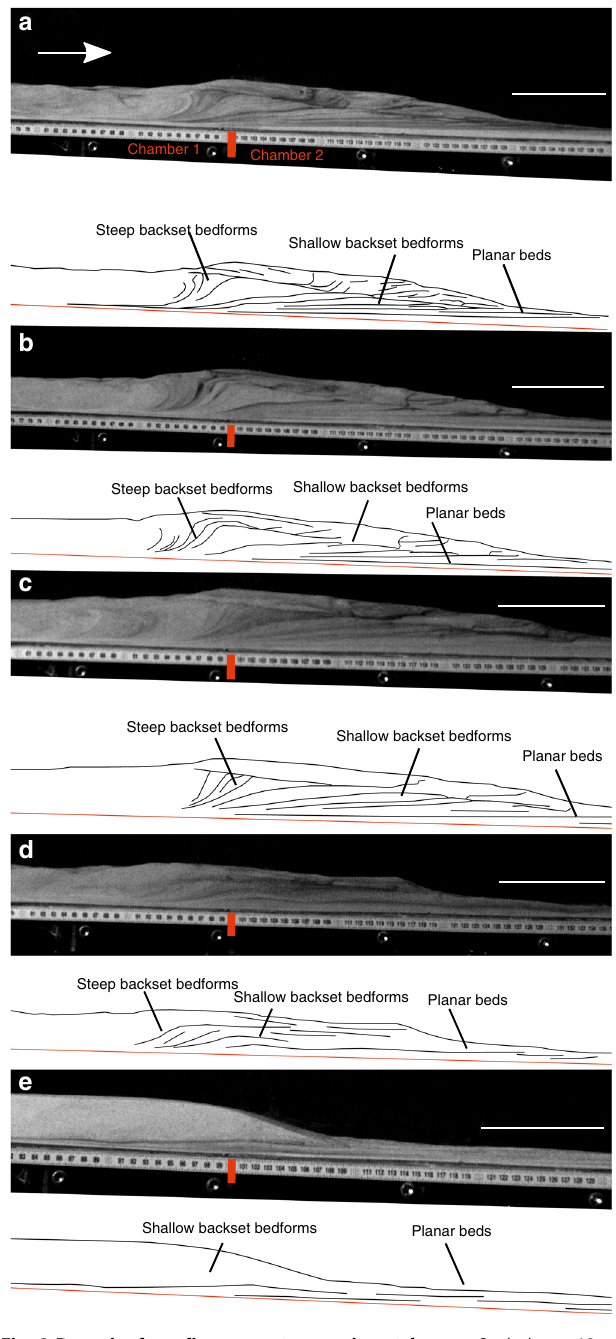
Fig. 2 Deposits from fi ve separate experimental runs. Scale bar =